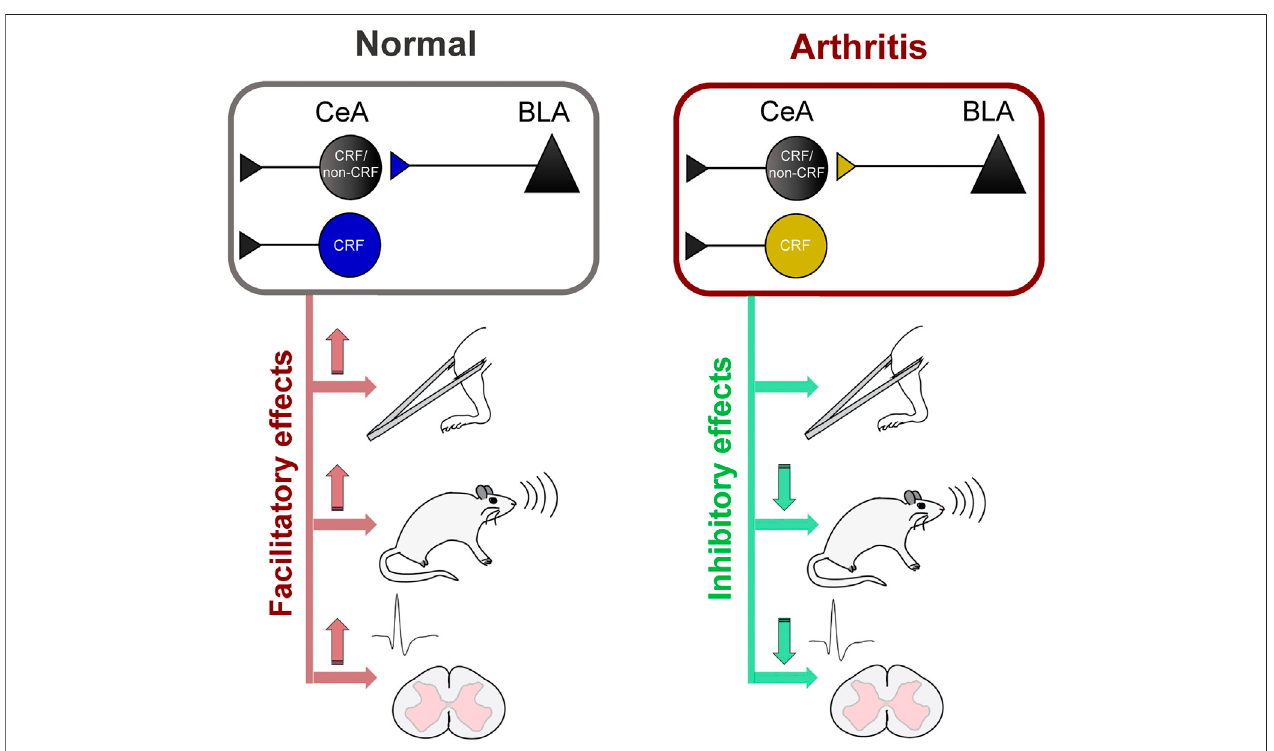
FIGURE7| Diagram summarizingkeyresults(Left) Activation ofBLA – CeAterminals orCeA – CRFneuronshasfacilitatoryeffects onspinalnociceptiveprocessing, vocalizationsandmechanicalwithdrawalthresholdsundernormalconditions(Right)SilencingofBLA – CeAterminalsorCeA – CRFneuronshasinhibitoryeffectsonspinal nociceptive processing and vocalizations, but not on withdrawal re fl exes, in an arthritis pain